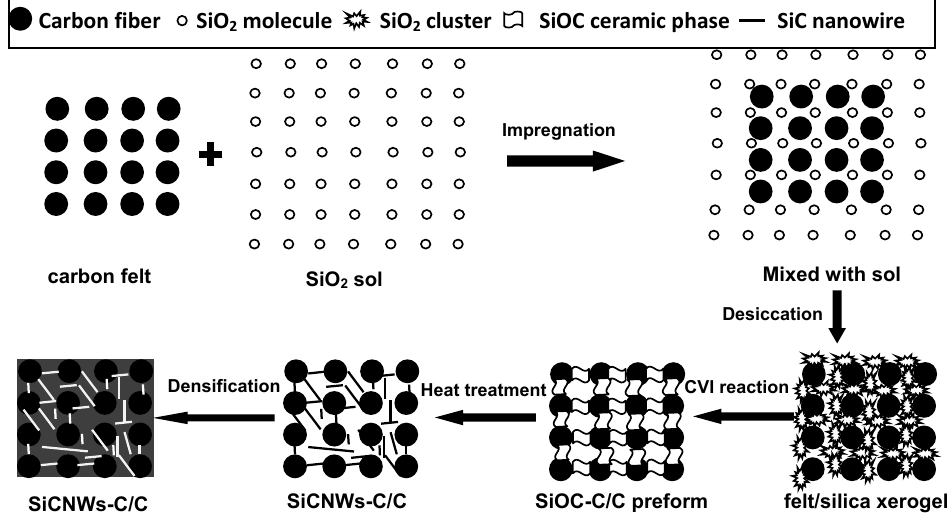
Figure 1. Schematic diagram of the formation of silicon carbide nanowires with carbon-carbon (SiCNW-C/C) composites. CVI = chemical vapor infiltration.